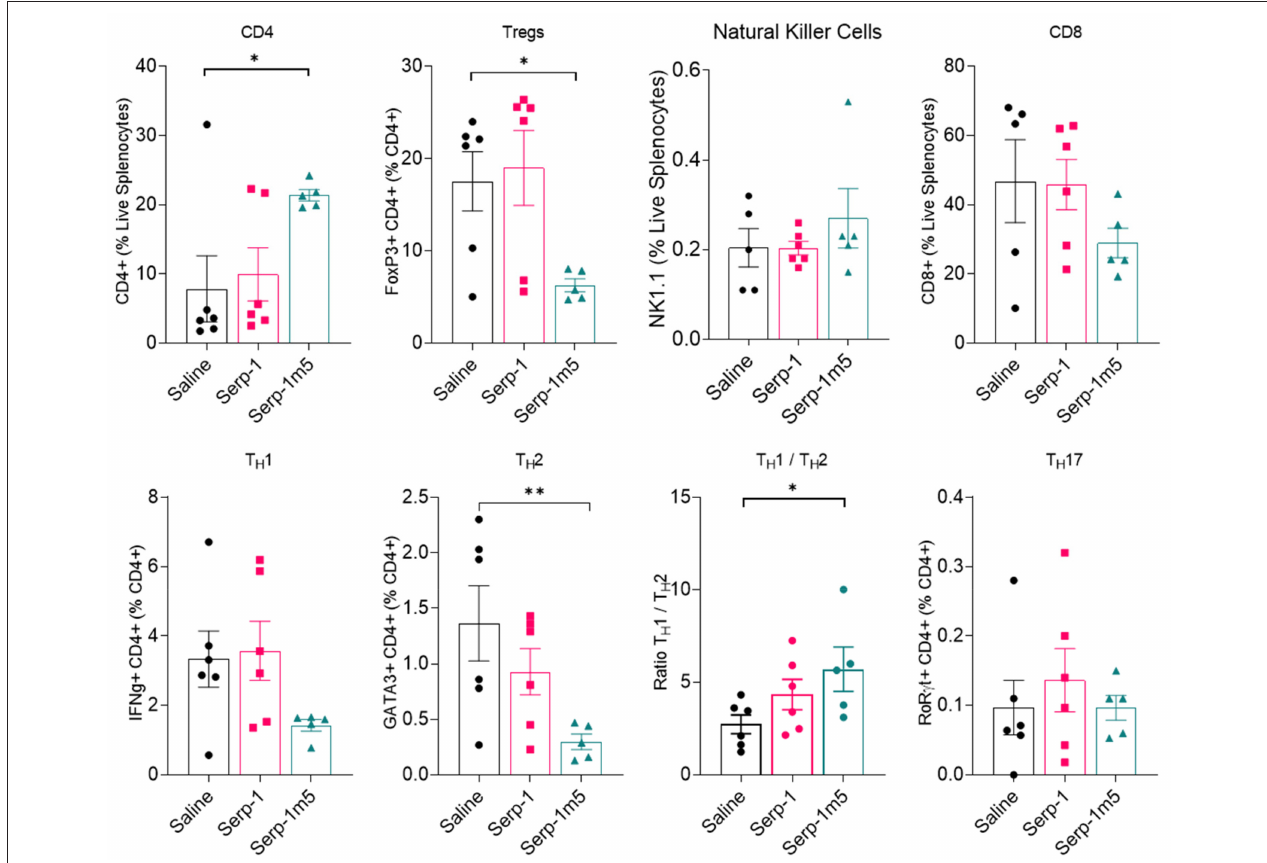
FIGURE 7 | Flow cytometry of lymphocytes indicate a decreased frequency of GATA3 + CD4 + Th2 cells ( p = 0.0097), Tregs cells ( p = 0.0285) in CD4 + T cells and increased frequency of CD4 + T cell in live splenocytes ( p = 0.0268), ratio of Th1/Th2 ( p = 0.0287) in Serp-1m5 treated mice compared with saline treated mice while no significant differences in the frequency of NK cells, CD8 + T cells, IFNg + CD4 + Th1 cells, Th17 cells in CD4 + T cells among the three groups. * p < 0.05, ** p < 0.01.